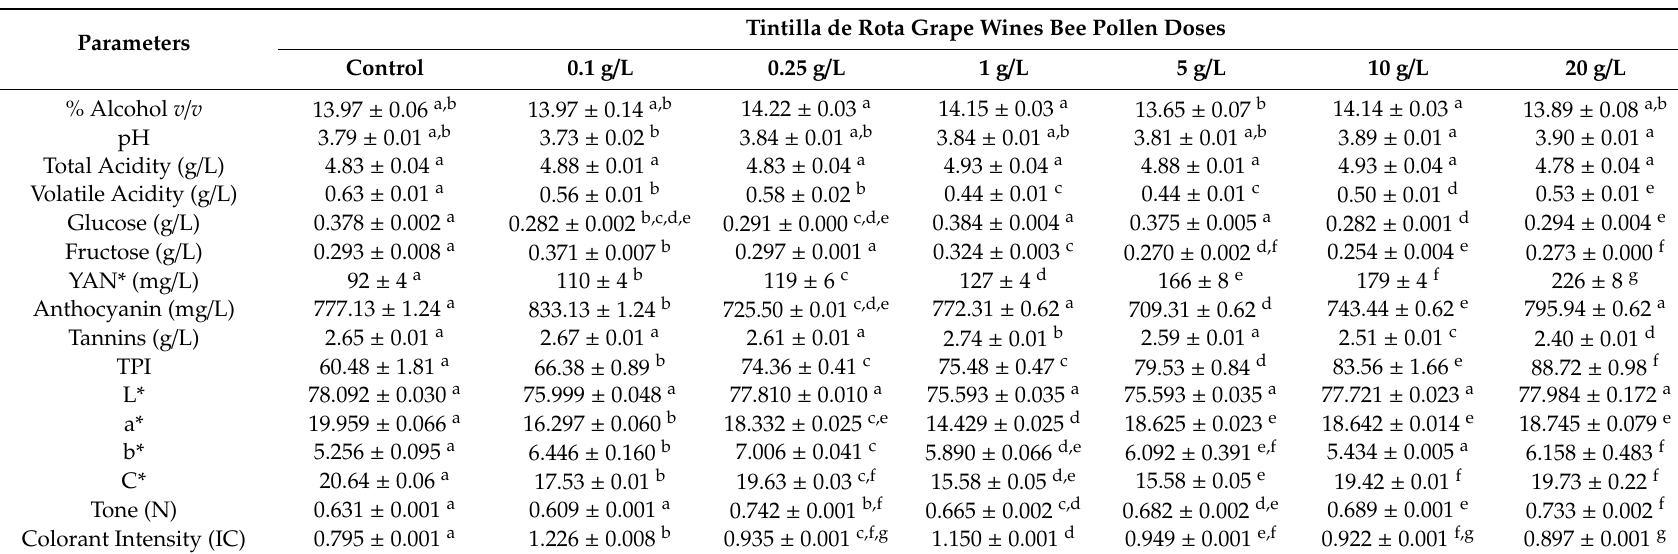
Table 2. Physicochemical composition of Tintilla de Rota wines with di ff erent doses of pollen (control, 0.1, 0.25, 1, 5, 10, and 20 g / L).